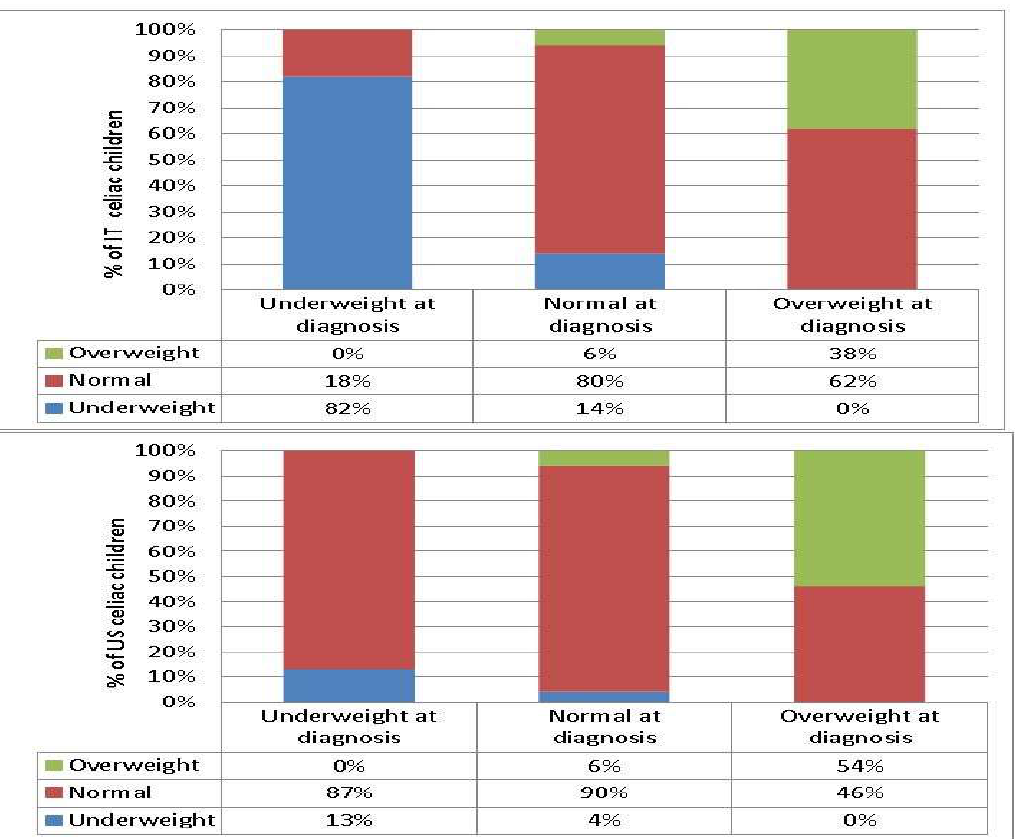
Nutrients 2020 , 12 , x FOR PEER REVIEW Figure 2. Gluten free diet (GFD) effect on BMI according to initial BMI in Italy and in the US. Figure 2. Gluten free diet (GFD) e ff ect on BMI according to initial BMI in Italy and in the US.